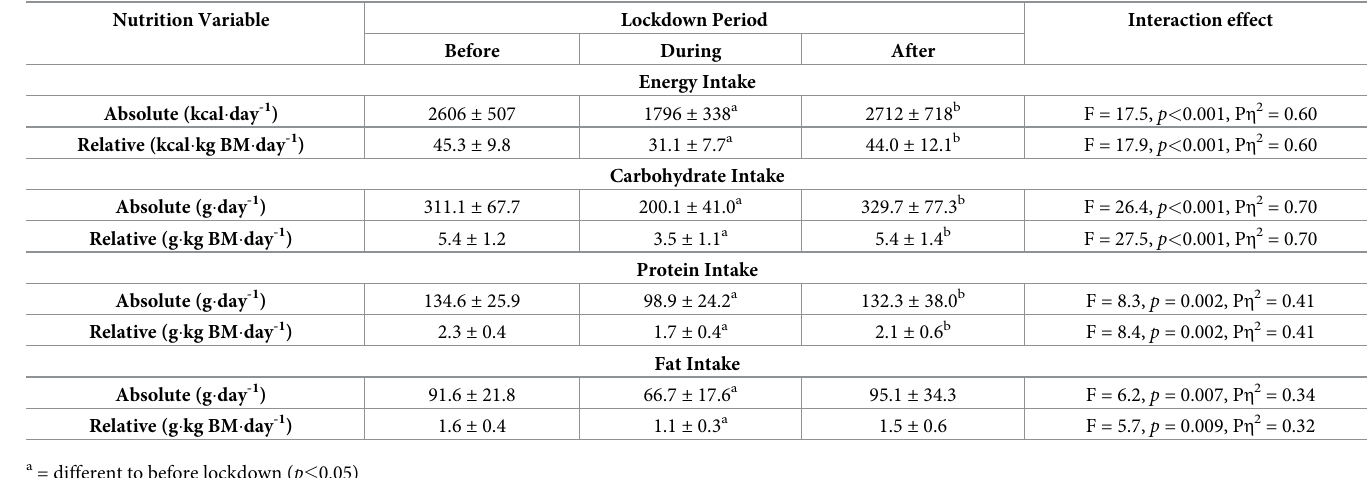
Table 2. Energy and macronutrient intakes of highly trained adolescent swimmers recorded before, during, and after the COVID-19 lockdown. Nutrition Variable Lockdown Period Interaction effect Before During After Energy